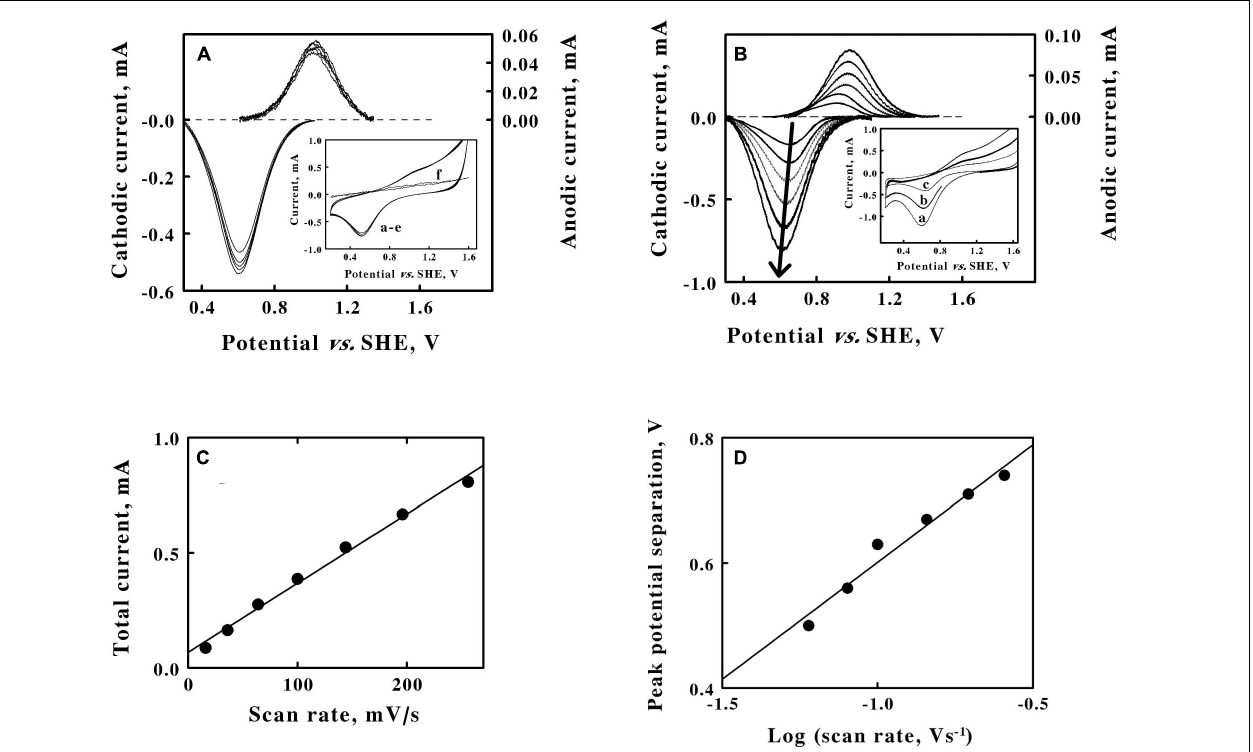
FIGURE 3 | Cyclic voltammetry on suspensions of intact F. acidiphilum in sulfuric acid, pH 1.5. (A) baseline-subtracted anodic ( positive, right ordinate ) and cathodic ( negative, left ordinate ) peak currents obtained with a scan rate of 256 mV/s at 5 suspensions of cells: 0.48, 0.96, 1.44, 1.92, and 2.4 × 10 9 cells/m. Inset , complete cyclic voltammograms for the same 5 suspensions in curves a through e ; all 5 voltammograms are essentially superimposable. Each of the five cyclic voltammograms in panel A represents the mean of four highly reproducible individual measurements whose values varied by less than 1% among the four measurements. Curve f is the cyclic voltammogram that was obtained using growth media that remained when the intact cells were removed by a combination of centrifugation and filtration. (B) Baseline-subtracted anodic ( positive, right ordinate ) and cathodic ( negative, left ordinate ) peak currents obtained with 1.44 × 10 9 cells/ml and 6 scan rates: 36, 64, 100, 144, 196, and 256 mV/s, from lower to higher magnitude currents, respectively. The bold arrow passes through the peaks of the currents associated with the cathodic curves . Inset , representative cyclic voltammograms obtained at scan rates of 256, 144, and 64 mV/s for curves a , b , and c , respectively. Each of the six cyclic voltammograms in panel B represents the mean of four highly reproducible individual measurements whose values varied by less than 1% among the four measurements. (C) Secondary plot of the total peak current as a function of the scan rate using data extracted from panels A, , respectively. (D) Secondary plot of the peak potential separation as a function of the logarithm of the scan rate using data extracted from panel B . Each datum in panels C,D represents the mean of four determinations. In all cases, the standard deviation of each datum was within the area bound by the diameter of the datum in the